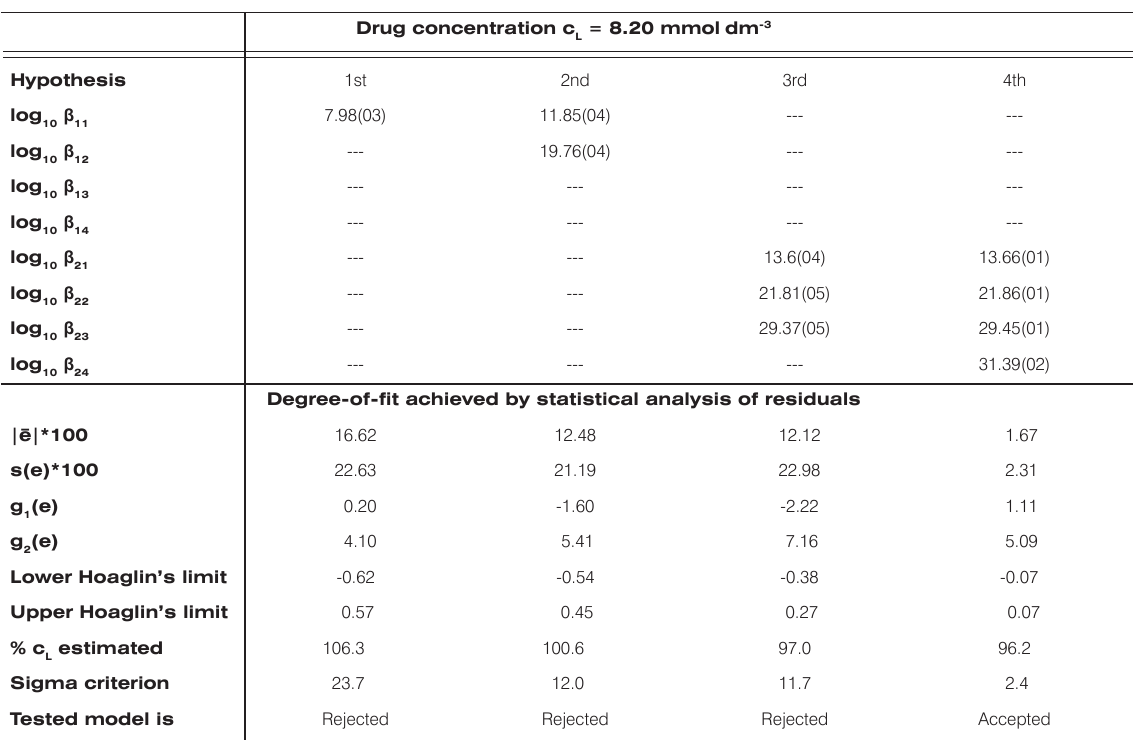
Table 1. for the best chemical model for the formation of dimers in the system H + -vildagliptin by regression analysis of one potentiometric titration curve ( cf ., Fig. 2) using the program HYPERQUAD. Standard deviations in units of the last digit(s) are given in